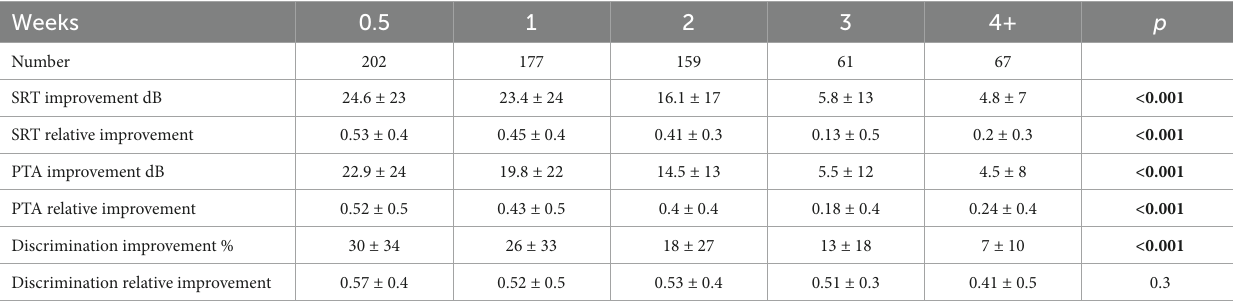
TABLE 3 Hearing improvement indicators at the end of the treatment according to treatment initiation time in weeks from symptom onset.